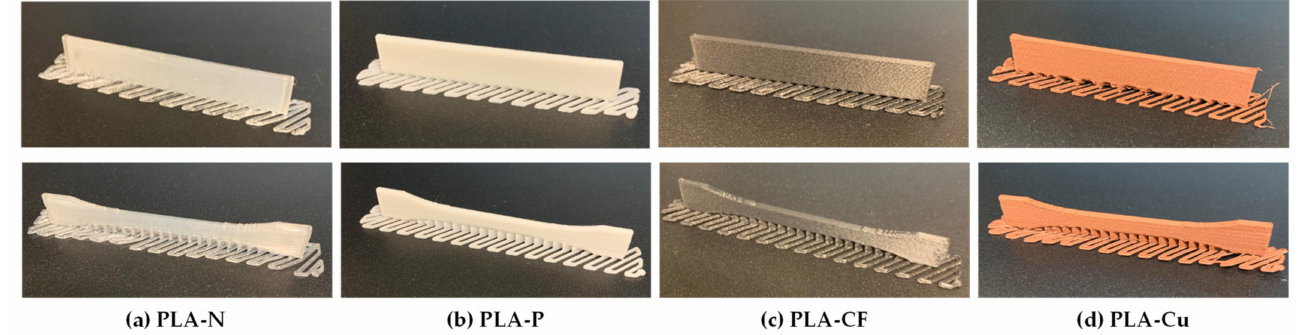
Figure 2. Bar (top) and dumbbell (bottom) 3D printed samples from bed temperature 60 ◦ C: ( a ) PLA-N; ( b ) PLA-P; ( c ) PLA-CF; and ( d )